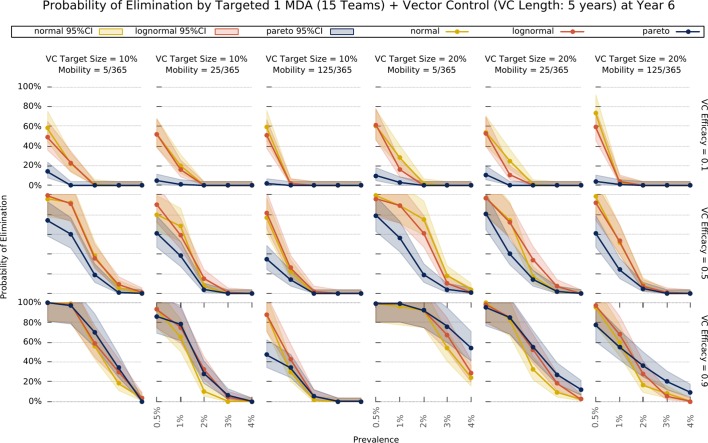
Elimination probability with a targeted approach.The same as in Figure 5, except that vector control is extended to last 5 years.